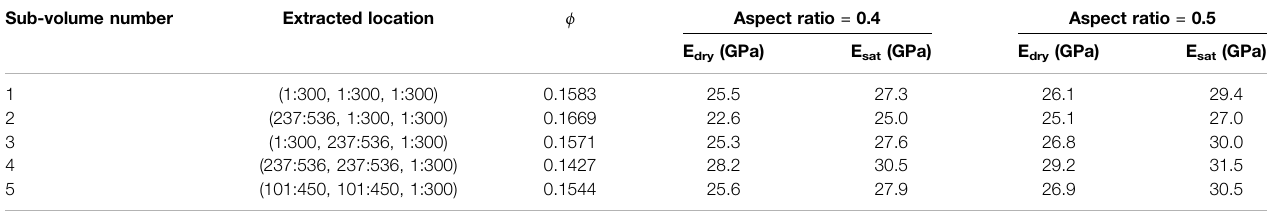
TABLE 1 | Numerical simulation results from the modi fi ed-SLOT. Sub-volume number